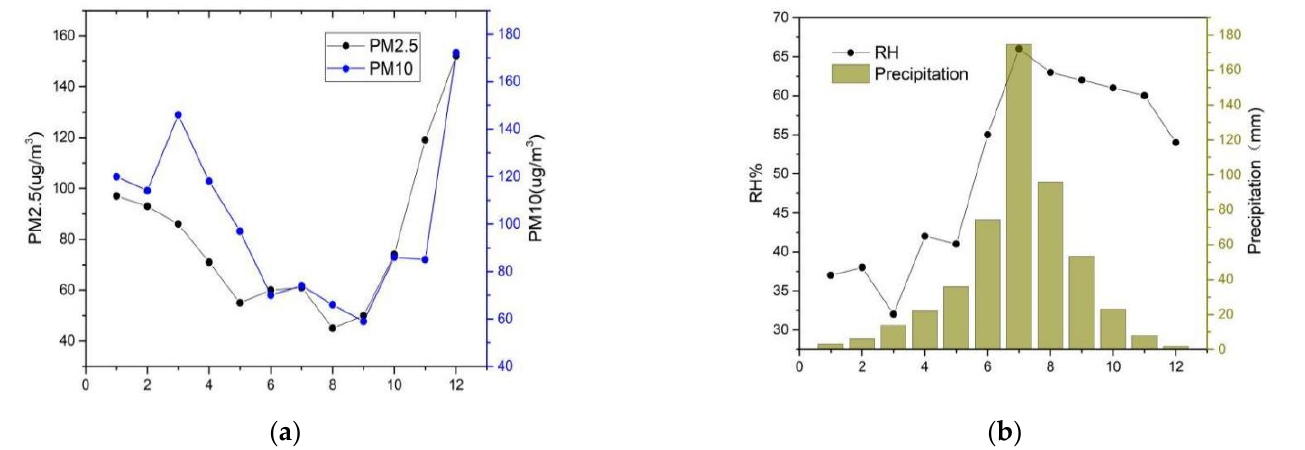
Figure 1. Site description: ( a ) trend chart of monthly pollutant concentration; ( b ) trend chart of monthly relative humidity and precipitation.